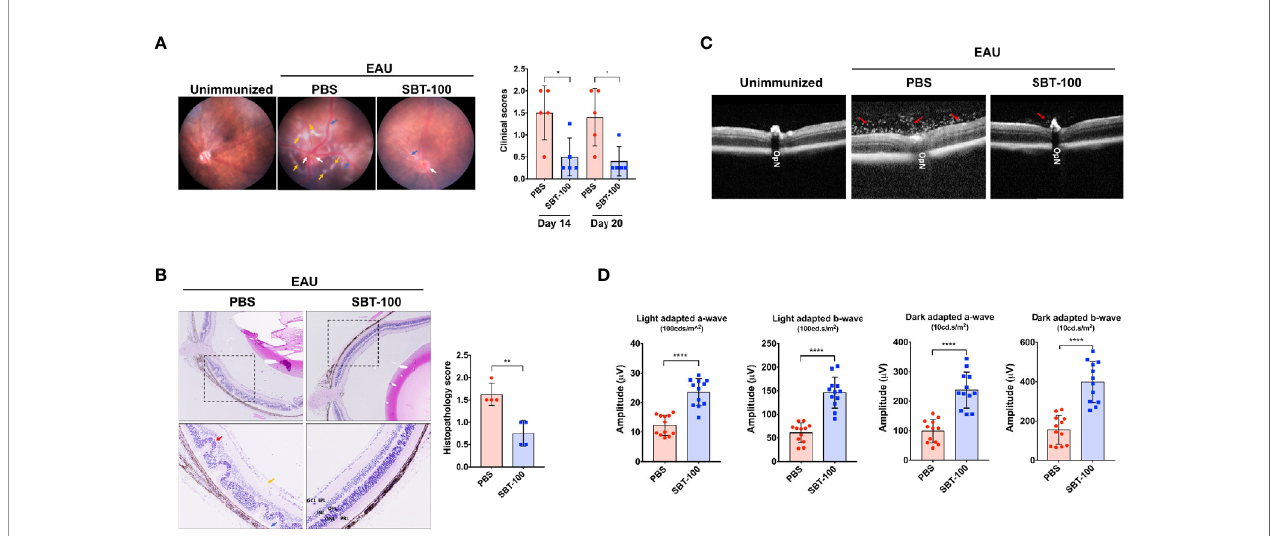
FIGURE 2 | SBT-100 ameliorates experimental autoimmune uveitis (EAU). C57BL/6J mice were immunized with IRBP 651-670 in CFA and treated with PBS or SBT- 100 and development of EAU was assessed by fundoscopy (A) , histology (B) , OCT (C) , or ERG (D) . Fundus images reveal in fl ammation with blurred optic disc margins and enlarged juxtapupillary area (white arrows), retinal vasculitis (blue arrows), and yellow-whitish retinal and choroidal in fi ltrates (orange arrows). Clinical scores and assessment of disease severity were based on changes at the optic nerve disc or retinal vessels and retinal and choroidal in fi ltrates (n = 5; from 5 mice). There were characteristic extensive retinal lesions with some con fl uent lesions due to in fl ammatory cell in fi ltration (yellow arrow), blurry optic disc margin (white arrow), and vasculitis (blue arrow) in the untreated EAU control mice, all of which were mild or absent in the SBT-100 treated mice. EAU score was signi fi cantly higher in the PBS-treated group as compared to the SBT-100 treated group. Histopathology of a cross-section of the eye was performed on Day 21 postimmunization (n=4; from 4 mice). Clinical and histopathology score guidelines were as previously reported. (C) OCT images show accumulation of in fi ltrating cells around the optic nerve and damage to the optic disc (red arrow). (D) Light-adapted (100 cd.s/m 2 ) and dark-adapted (10 cd.s/m 2 ) a- and b-waves on Day 18 postimmunization were signi fi cantly lower in the untreated mice compared to the SBT-100 treated group (n=12; 2 eyes from 6 mice). OpN, optic nerve; GCL, ganglion cell layer; INL, inner nuclear layer; ONL, outer nuclear layer; IPL, inner plexiform layer; OPL, outer plexiform layer; PRL, photoreceptor layer. Data represent at least three independent experiments and presented as mean ± SEM. (* p < 0.05; ** p < 0.01; **** p <